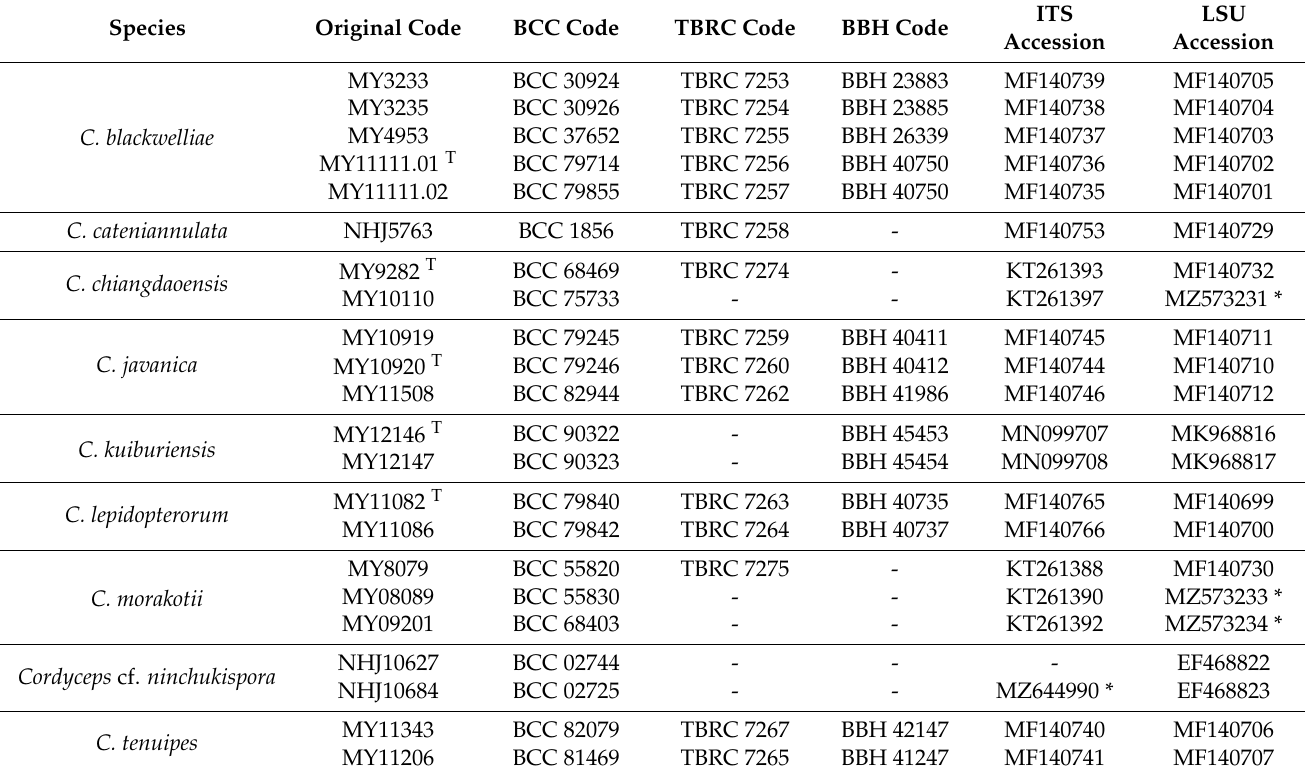
Table 1. Strains of nine Cordyceps species included in this study (* = Obtained in this study; T = Type strain).